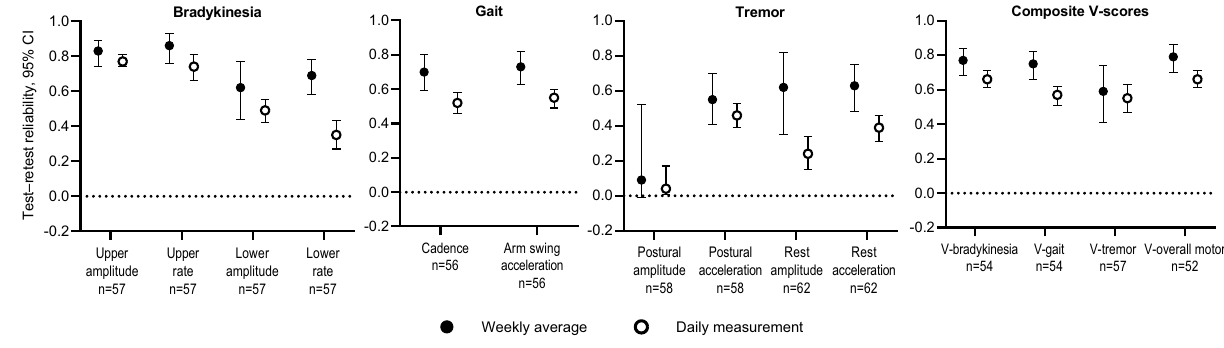
Figure 6. Test–retest reliability of VME single-sensor–derived features and composite V-scores during the post-hospitalization home-based assessment. Test–retest reliabilities are reported for daily measurements and weekly averages of all scores for the OFF and ON states during the post-hospitalization period. Test–retest reliability was considered poor for ICCs < 0.5, average for ICCs 0.5–0.75, good for ICCs > 0.75–0.9, and excellent for ICCs > 0.9. CI confidence interval, ICC intraclass correlation coefficient, V-score machine-learned composite sensor scores for each motor feature, VME virtual motor